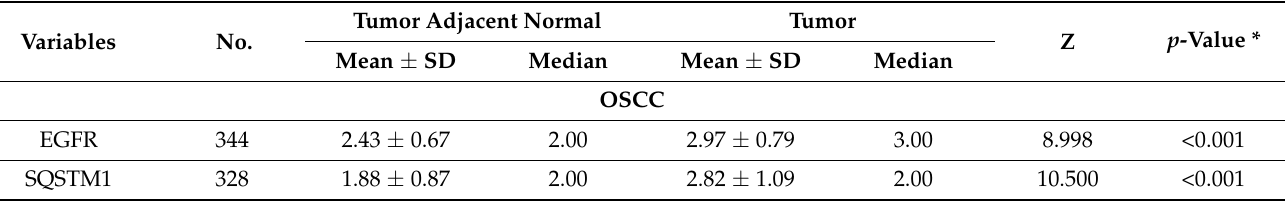
Table 1. The comparison of EGFR and SQSTM1expressions between corresponding tumor adjacent normal and tumor tissues in OSCC